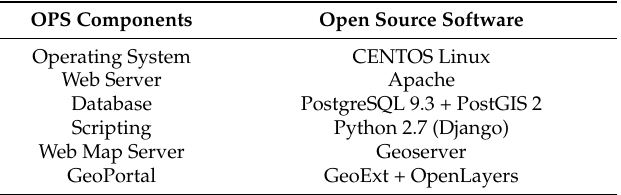
Figure 4. A modified version of Figure 3 showing the software selected to fill each OPS component role. Table 1. Selected open-source software for building the OPS infrastructure.